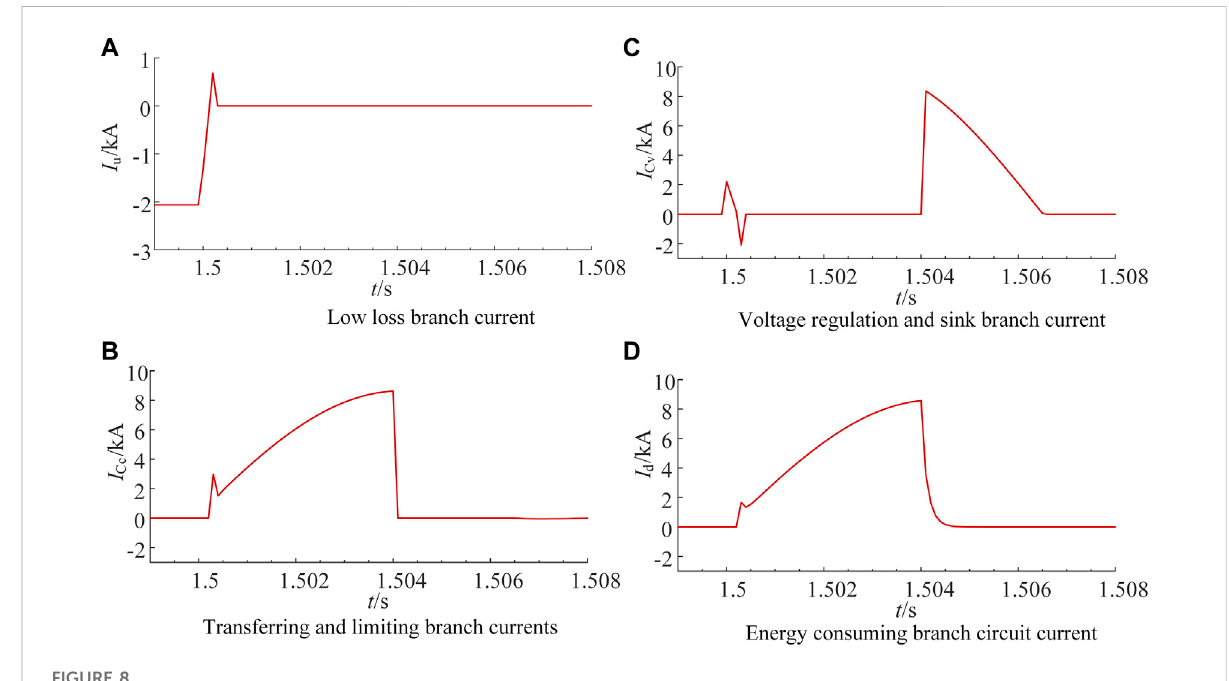
FIGURE 8 DC fault current opening and closing curves.